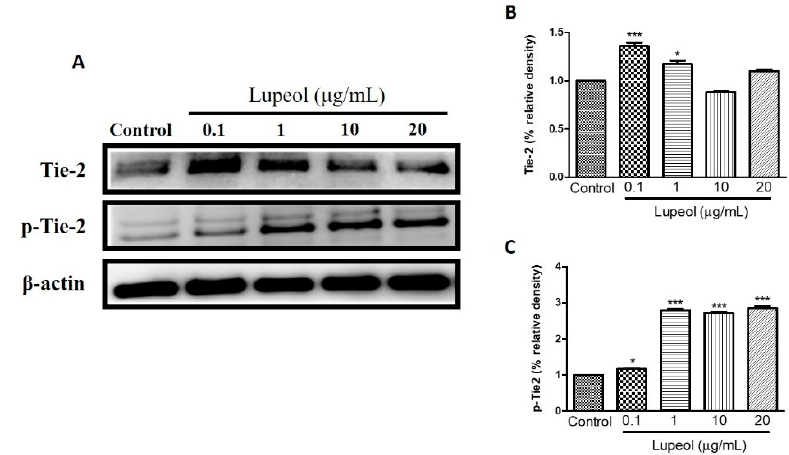
Figure 8. Lupeol regulates the expression of Tie-2 in epidermal keratinocytes. ( A ) Western blot showing expression of Tie-2 and p-Tie-2 in keratinocytes after 24 h treatment with lupeol in different concentrations. ( B , C ) All the proteins were semi-quantitated using Image J software and normalized to the levels of β -actin. Data are expressed as mean ± SEM. * p < 0.05 and *** p < 0.001 versus control group.